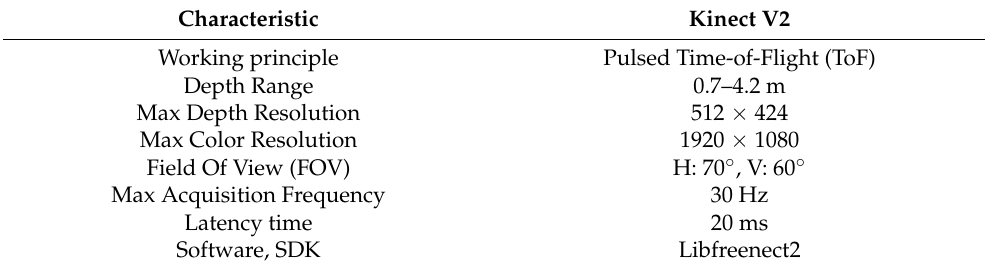
Table 1. Kinect V2 characteristics [20].